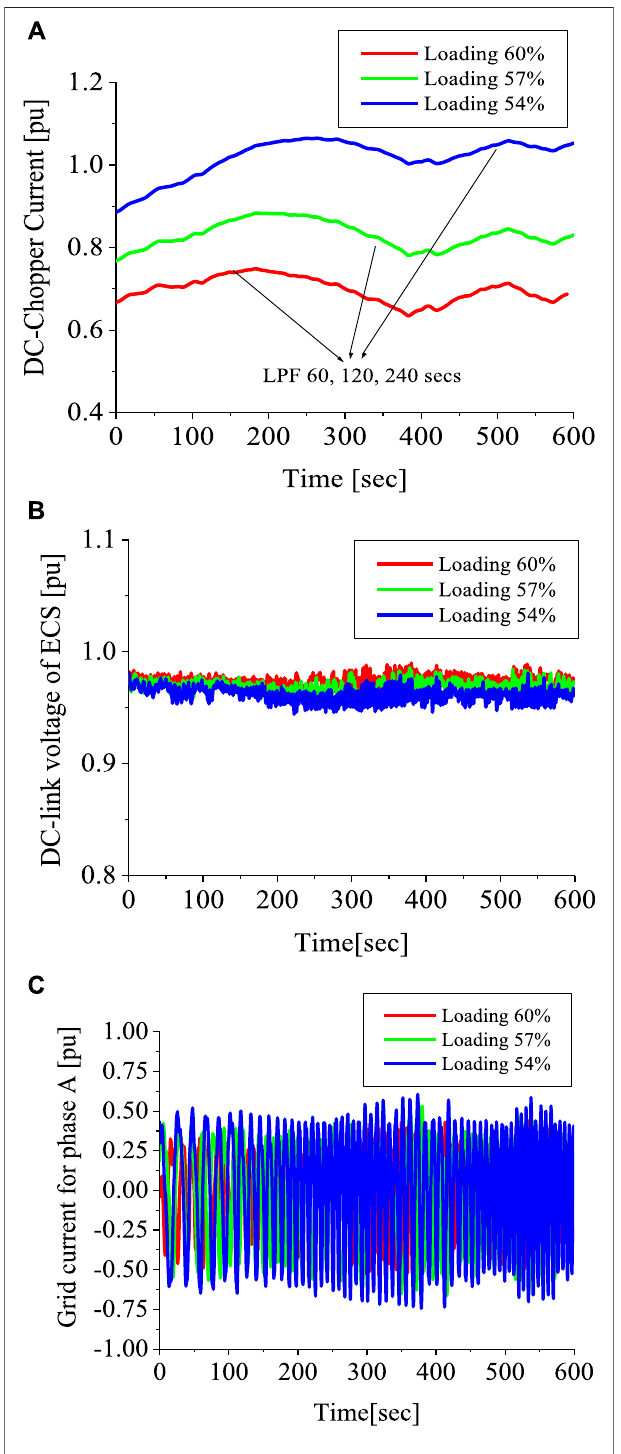
system. (C) Grid current of energy capacitor